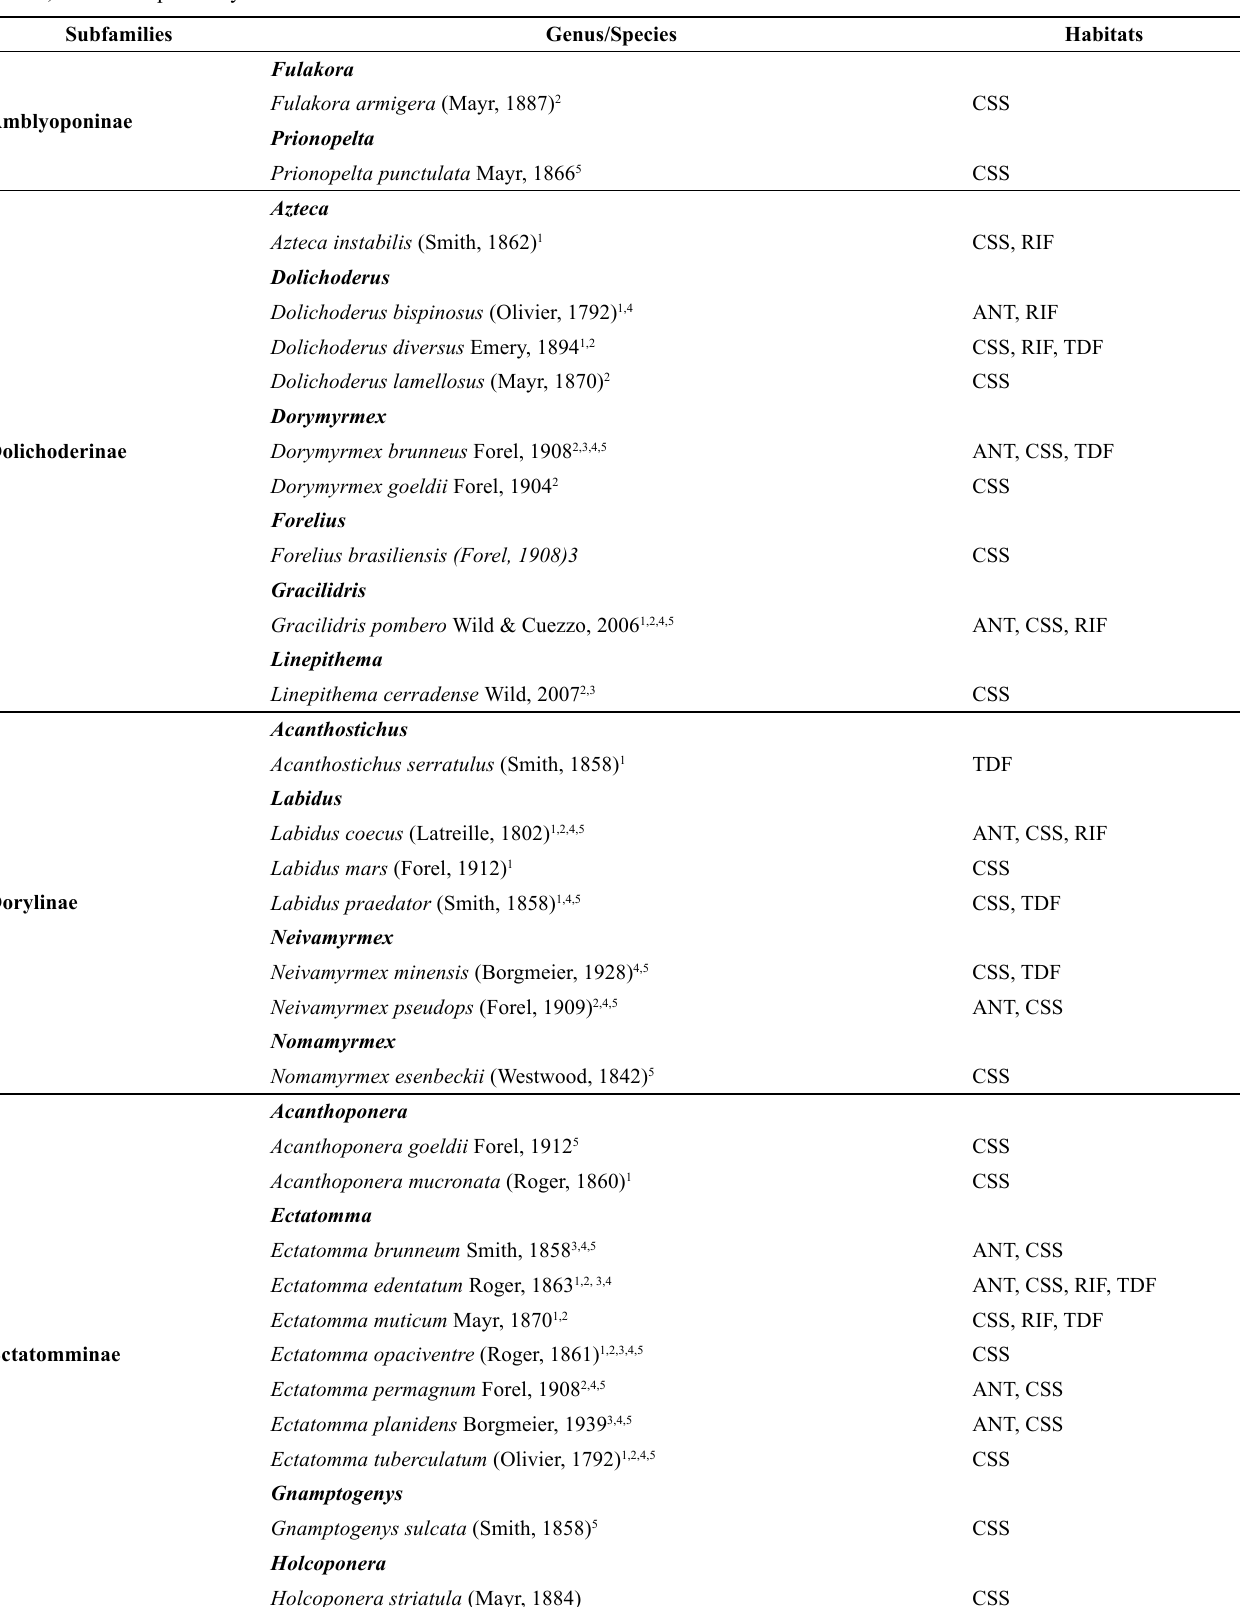
Table 2 . Taxa recorded for APA Pandeiros. Species indicated with an asterisk (*) represent new records for the state of Minas Gerais, two asterisks (**) represent new records for Brazil, and three asterisks (***) represent new records for South of America. The numbering provided after the species name represent different datasets: (1) Queiroz-Dantas et al., 2011 and Neves et al., 2013; (2) Vasconcelos et al., 2018; (3) Rabelo et al., 2021; (4) Santiago, unpublished data from Santiago 2015 and Santiago et al., 2020; (5) Santiago, unpublished data from Santiago 2019. Non-numbered species represent data included in this work. CSS = Cerrado sensu stricto , RIF = Riparian Forest, ANT = Anthropogenic habitats, TDF = Tropical Dry